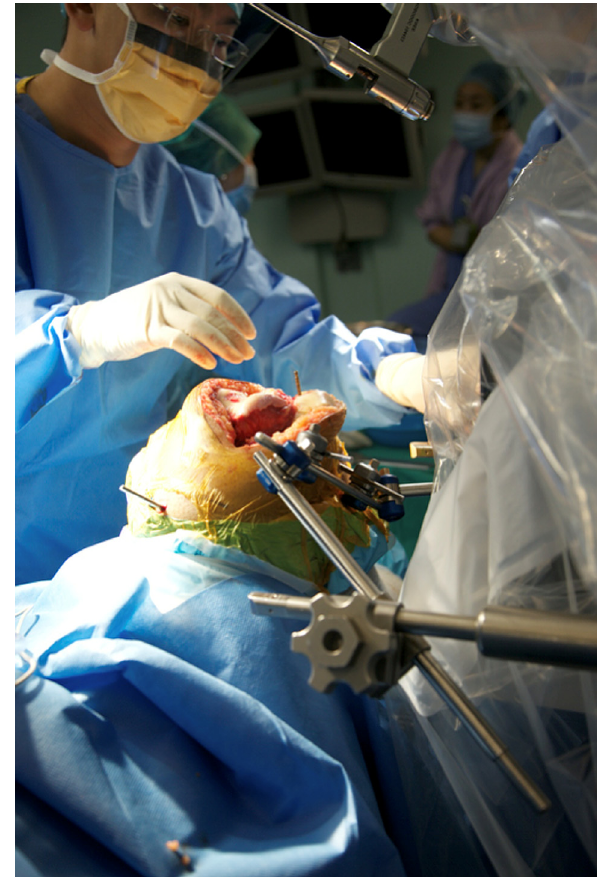
Figure 2. Customized foot and thigh holder. Figure 3. Rigid mating of the patient to TCAT